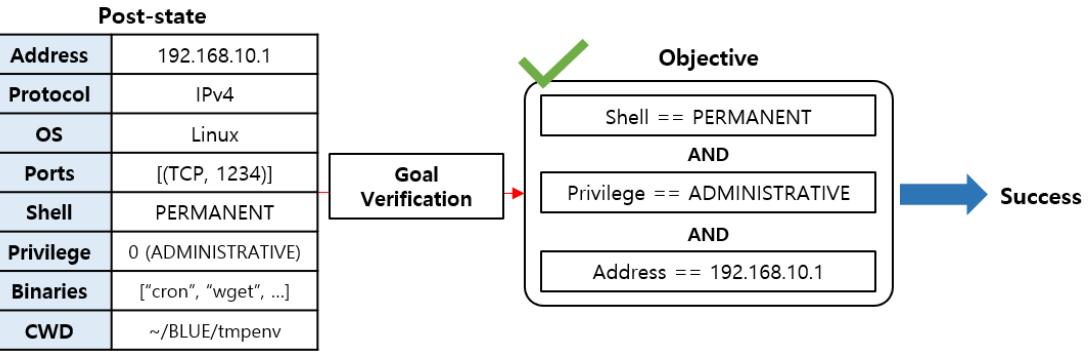
Figure 12. The example of the process of scenario performance: RAT installation.